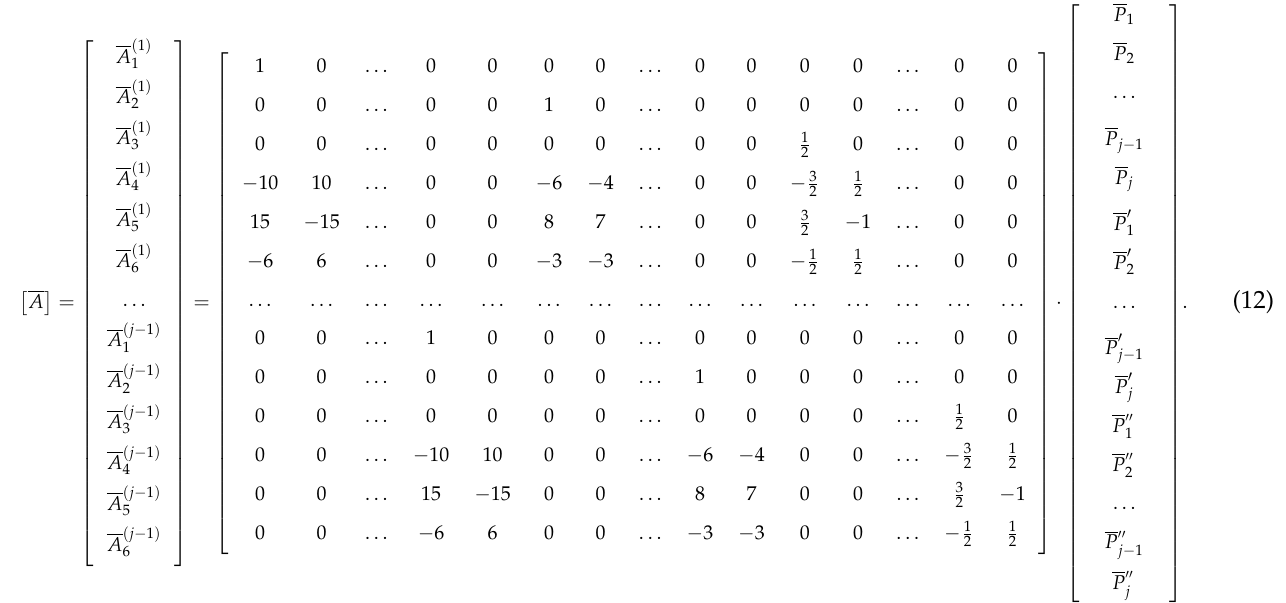
Algorithm 1 For obtaining a spline curve with polynomial equations of the fifth degree of segments